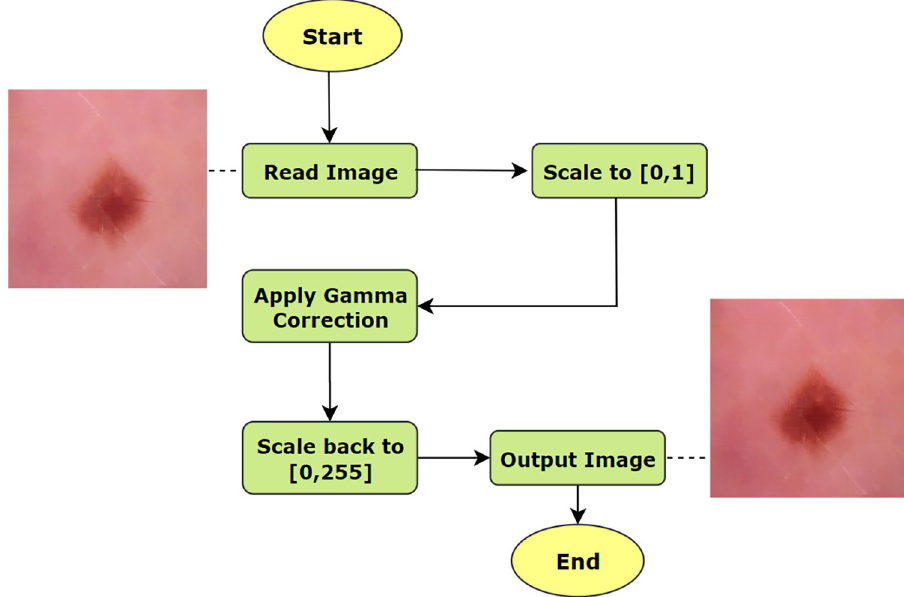
Fig 9. Process flow of applying gamma